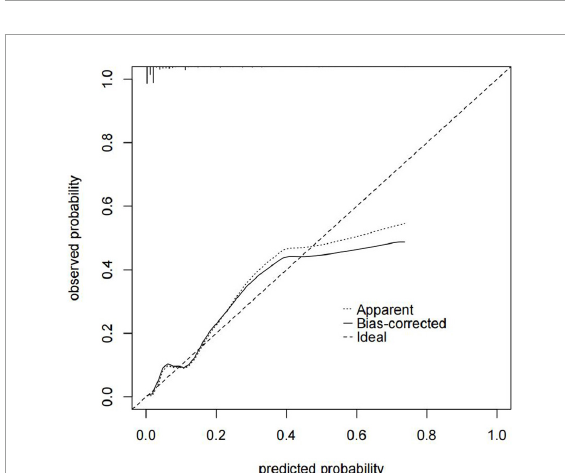
FIGURE7 DCA for the predictive nomogram. The y-axis represents the net benefit. The “None” line is the net benefit of intervening no patients. The “All” line is the net benefit of intervening all patients. Solid red line is the net benefit of intervening patients on the basis of the nomogram. The generated curve indicated that at a threshold probability ranging from approximately 4–88%, the nomogram model can be beneficial for making the decision to intervene. DCA, decision curve analysis.